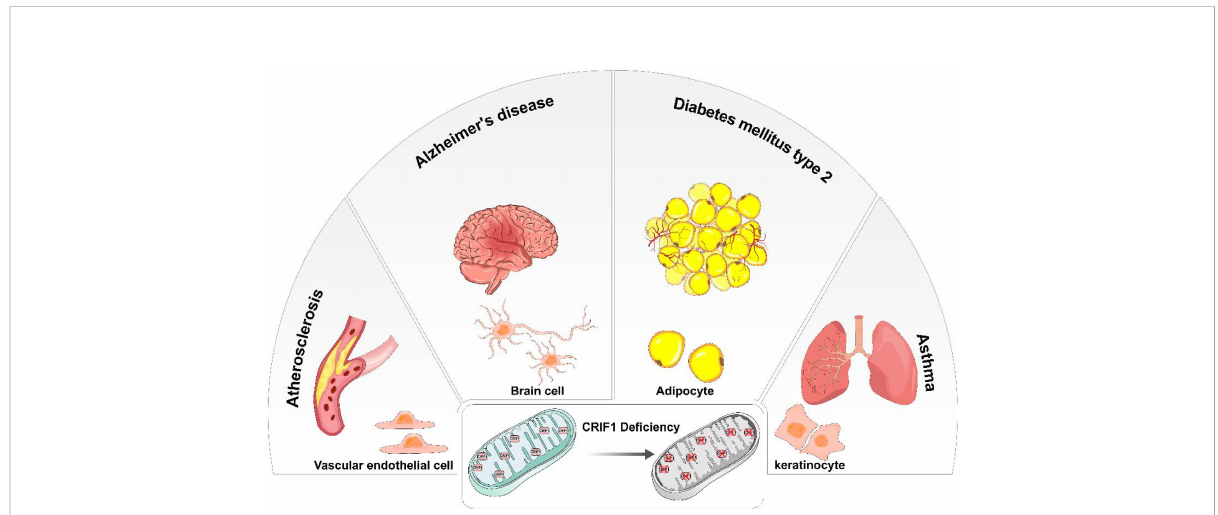
FIGURE 2 In different types of cells, CRIF1 de fi ciency induces mitochondrial dysfunction and eventually causes different diseases. In vascular endothelial cells, mitochondrial dysfunction induced by CRIF1 de fi ciency potentially causes atherosclerosis. In brain cells, mitochondrial dysfunction induced by CRIF1 de fi ciency potentially causes Alzheimer ’ s diseases. In adipocytes, mitochondrial dysfunction induced by CRIF1 de fi ciency potentially causes diabetes mellitus type 2. In keratinocytes, mitochondrial dysfunction induced by CRIF1 de fi ciency potentially causes